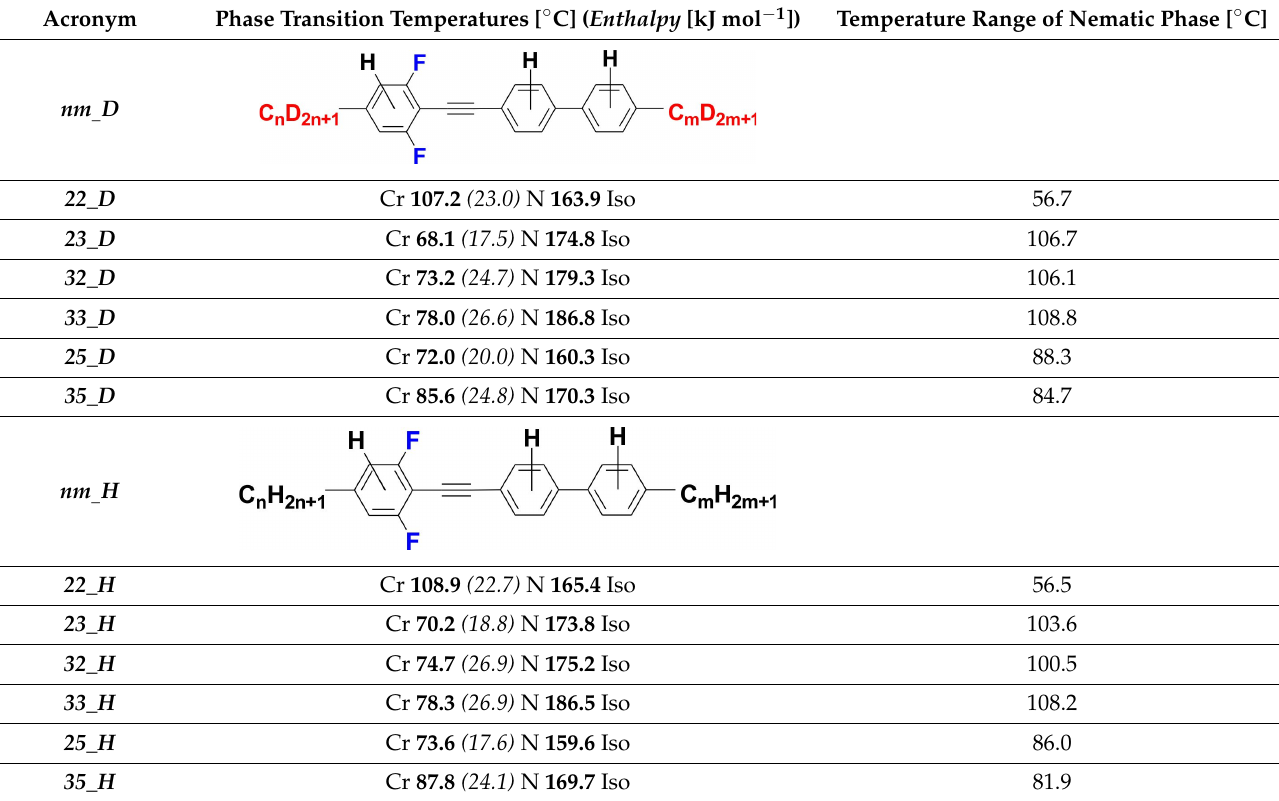
nm _ H — Table 1 and Figure 3. Differential scanning calorimetry graphs of investigated compounds were gathered in Supplementary Materials. Table 1. Phase transition temperatures (°C) and enthalpies (kJ · mol − 1 ) from DSC measurements obtained during heating cycles. Acronym